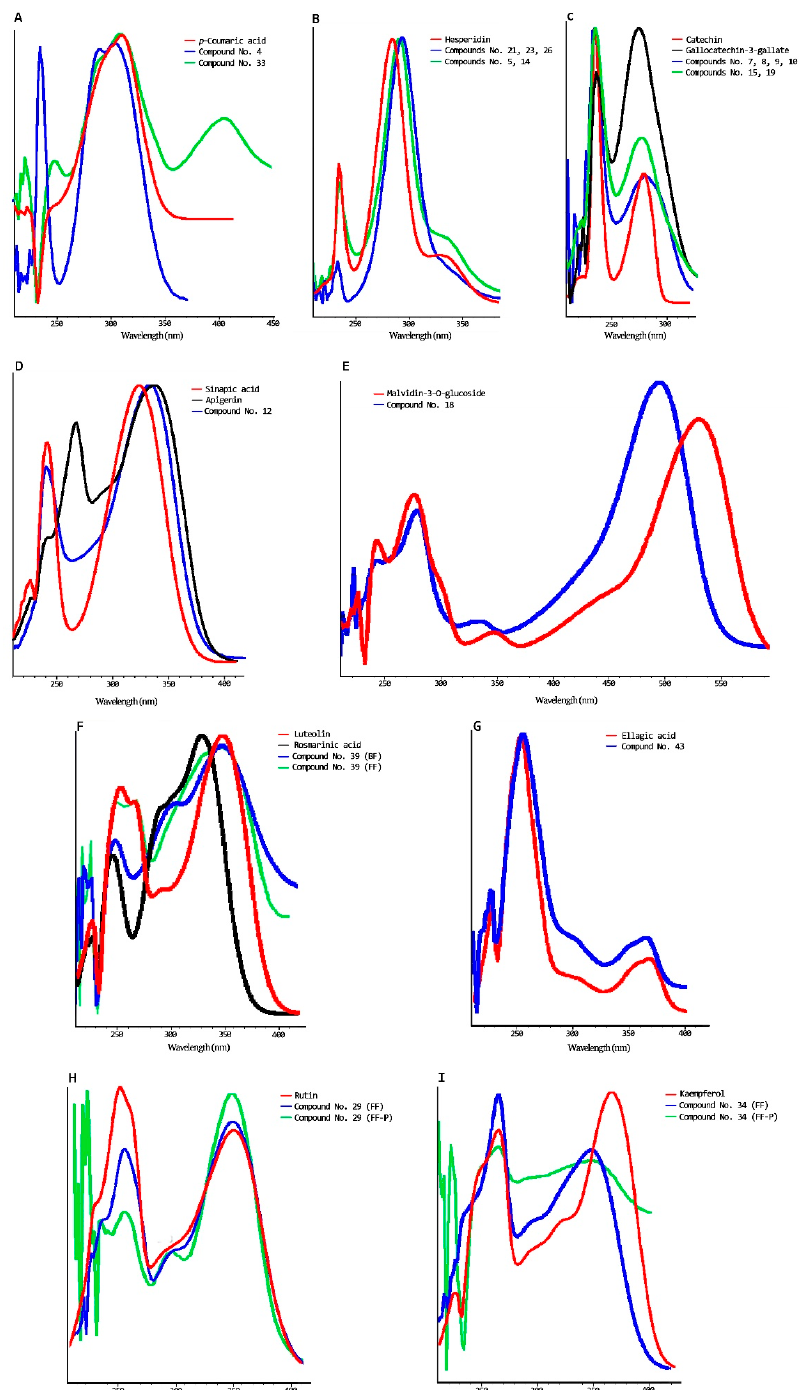
Figure 2. UV spectra of many standard and polyphenols detected in persimmon flour obtained from juice coproducts (cv. Rojo Brillante) and enriched pork liver p â t é samples. Image caption: ( A ). p -coumaric acid and compounds No. 4 and 33; ( B ). Hesperidin and compounds No. 5, 14, 21, 23, 26; ( C ). Catechin, gallocatechin 3-gallate and compounds No. 7, 8, 9, 10, 15 and 19; ( D ). Sinapic acid, apigenin and compound No. 12; ( E ). Malvidin-3-O-glucose and compound No.18; ( F ). Luteolin, rosmarinic acid and compound No. 39 found in bound and free fractions; ( G ). Ellagic acid and compound No. 43. ( H ). Rutin and compound No. 29 found in persimmon flour and enriched p â t é in the free fraction; ( I ). Kampferol and compound No 34 found in persimmon flour and enriched p â t é in the free fraction.BF: Bound fraction; FF: free fraction; FF-P: polyphenol detected in the free fraction of the enriched p â t é